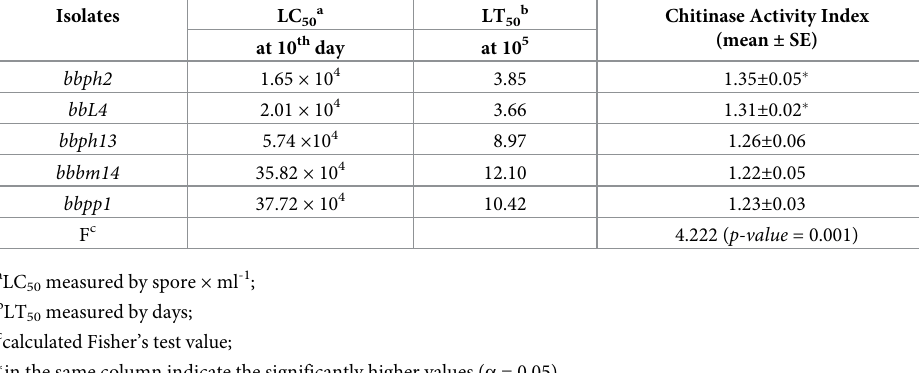
recorded after ten days for all the selected isolates (Fig 3f). The FDI was 0 in the case of the first spore concentration, but when 10 3 spores were inoculated, small melanic spots appeared on some larvae (0.5 � FDI > 0; Table 1; Fig 3g). At a spore concentration of 10 4 , the mortality arose up to 26% in the case of the bioassays with bbL4 and bbph2 isolates; however, no mortal- ity was recorded with bbph13 and bbbm14 isolates. The increased mortality was accompanied by a significant difference in FDI values between the isolates; the highest values were recorded = 0.9, FDI = 0.83), indicating the presence of large melanic for bbL4 and bbph2 (FDI bbL4 bbph2 spots on most of the larvae (Fig 3g). At a spore concentration of 10 5 , the mortality reached 100% in the case of isolate bbph2 , followed by isolate bbL4 (93%). The two isolates bbpp1 and bbbm14 caused mortality lower than 50% of the E . kuehniella larvae. At the highest tested spore concentration (i.e., 10 6 ), isolates bbph13 , bbph2 and bbL4 caused a larvae mortality of 100% vs. less than 70% in the case of bbpp1 and bbbm14 , with an FDI of 1.57 and of 1.53, respectively (Fig 3h and 3i). Estimation of the LC showed that isolates bbph2 and bbL4 had the lowest values, with 50 1.65 × 10 4 spores/ml and 2.01 × 10 4 spores/ml, respectively (Table 2, S1 and S2 Figs). For these values, at a spore concentration of 10 5 , were estimated to be 3.85 and two isolates, the LT 50 3.66 days, indicating their higher level of aggressiveness (Table 2). Table 2. Aggressivity assessment of selected isolates of Beauveria bassiana .